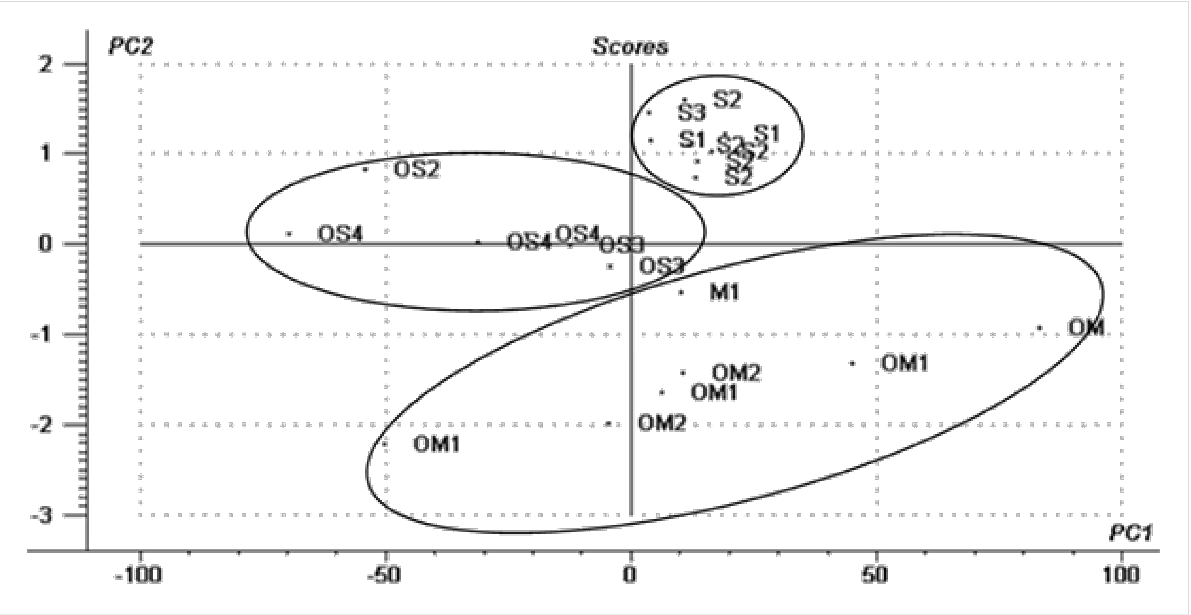
Figure 2: The score plot from the PCA analysis of the O. basilicum L. essential oil compounds nanoencapsulation in β -CD (classification as acyclic or cyclic (numbered) mono- and sesquiterpenoid hydrocarbons (M and S), or the corresponding oxygenated terpenes (OM and OS); the encapsulation efficiency and hydrophobicity were the PCA